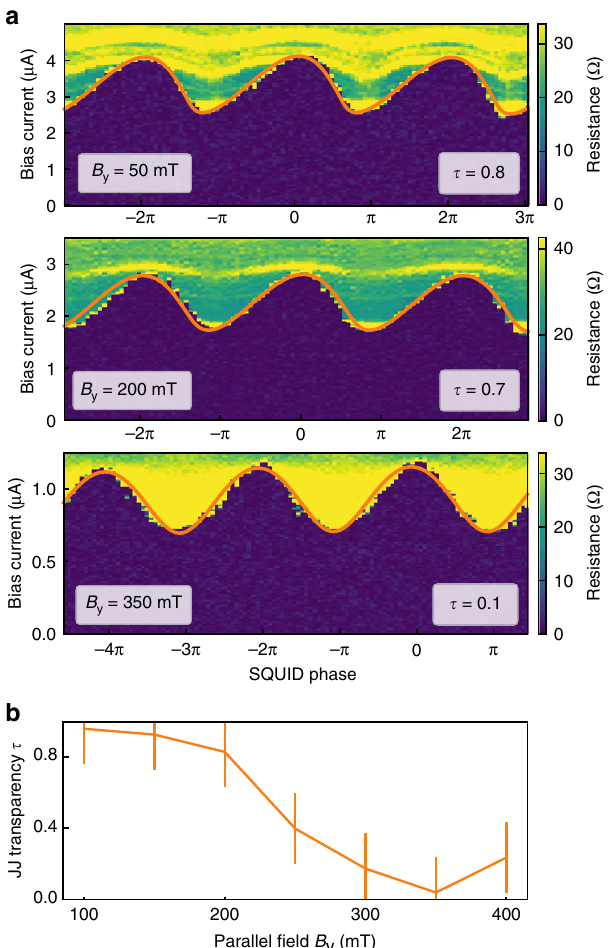
Fig. 2 Current-phase measurement of SQUID. a Resistance of the device as a function of the phase bias applied on the SQUID and the bias current in the presence of an in-plane fi eld along the y direction at B y = 50 mT, B y = 200 mT and B y = 350 mT. V 1 is set to − 2 V and V 2 to − 4.5 V g g (cid:3) 4 I 2 resulting in I 1 . The oscillation of the critical current present a visible c c forward tilt at 50 and 200 mT absent at 350 mT. b Evolution of the transparency of JJ2 as a function of the in-plane fi eld B y as determined from fi tting the SQUID oscillation at different gate and fi elds (see “ Methods ” ). The error bars correspond to typical variations observed across different similar data